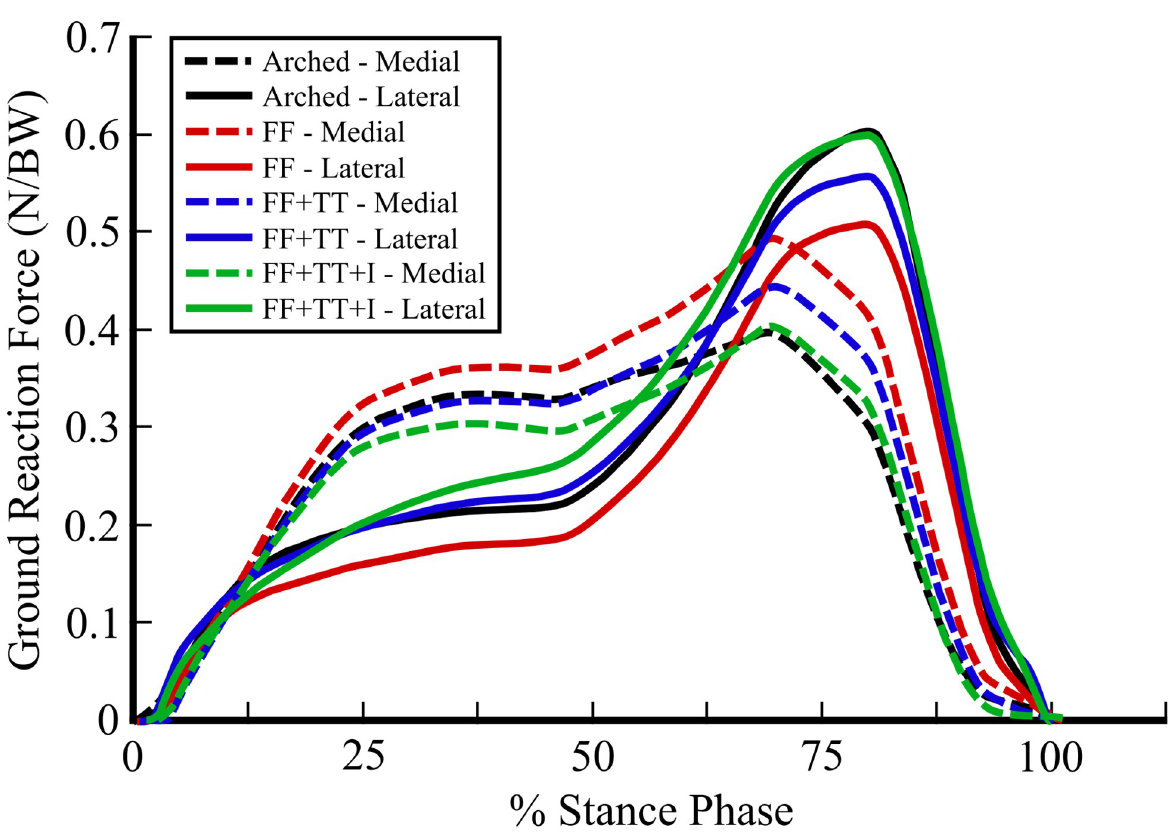
Fig 10. Medial-lateral split of vertical ground reaction forces. The medial/lateral split of vertical ground reaction forces generated by gait simulations using an arched foot (arched; black), flatfoot (FF; red), flatfoot with tendon transfer (FF+TT; blue), and flatfoot with implant-modified tendon transfer (FF+TT+I; green) model. The results are normalized by body weight (BW).